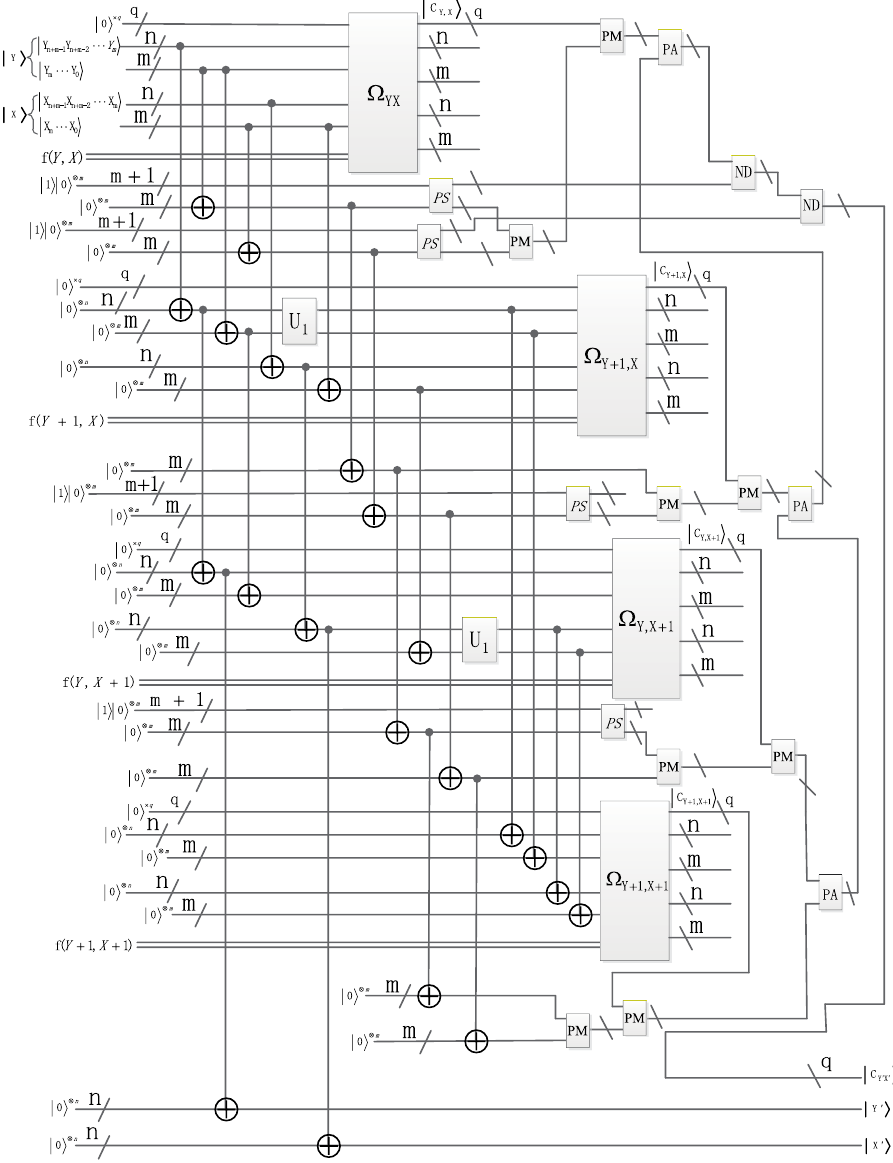
Figure 23. The scaling-down circuit of bilinear interpolation method for